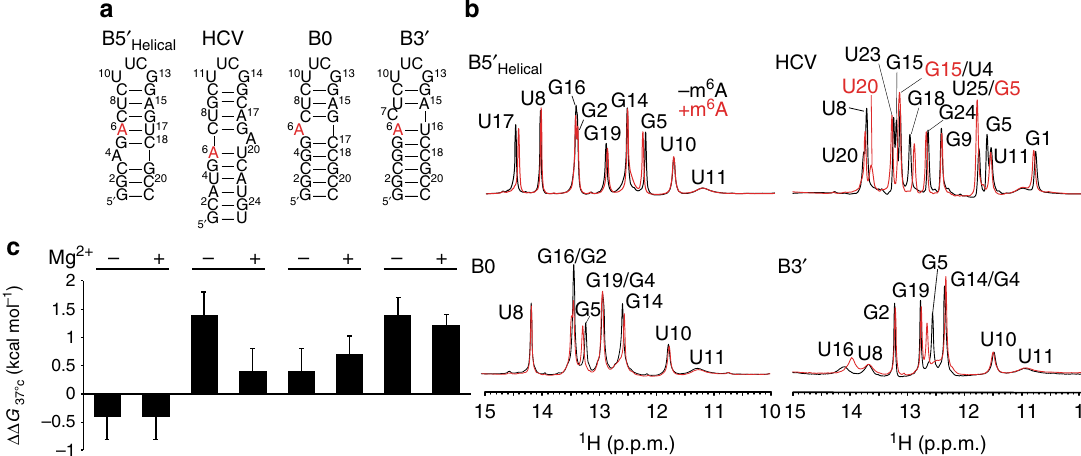
Fig. 2 Structural requirements for m 6 A stabilization of junctional A – U base pairs. a Hairpin constructs that vary the secondary structural context of m 6 A. Secondary structures are predicted using MC-fold 39 and supported by NMR data (see Supplementary Fig. 3c). The HCV sequence is derived from the base of stem loop 1 (SL1) in the 3 ʹ end of HCV genome (nt 9633-9642 linked by UUCG to nt 9668-9678) from the genotype 2A JFH1 strain (GeneBank accession: AB047639 [https://www.ncbi.nlm.nih.gov/nuccore/AB047639]). b Comparison of 1 H NMR spectra of unmodi fi ed and m 6 A6 substituted hairpin constructs recorded in 15 mM sodium phosphate, 25 mM NaCl, 0.1 mM EDTA and 3 mM Mg 2 + at pH 6.4 and 10 °C. c Impact of methylation on the thermal stability of the hairpins with and without 3 mM Mg 2 + . Shown are the differences in the free energy of melting between methylated and unmodi fi ed RNA, i.e., ΔΔ G = Δ G (methylated) − Δ G (unmodi fi ed). The uncertainty re fl ects the standard deviation from at least three measurements